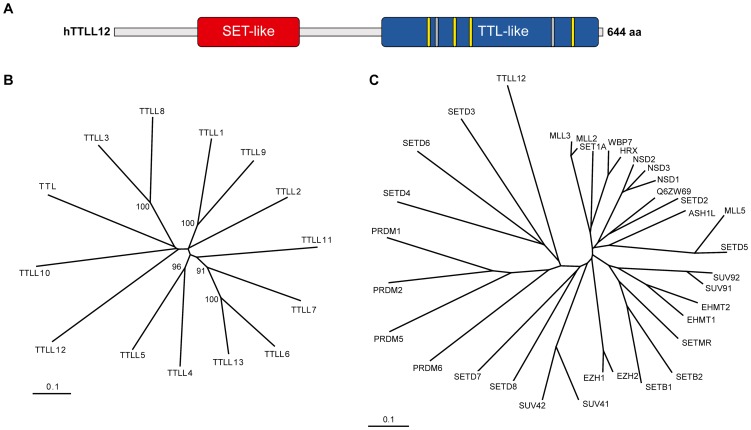
hTTLL12, domain organisation and similarity with other proteins.
A. Schematic representation. Red indicates the SET-like domain (amino acids 91–249), blue the TTL-like domain (amino acids 353–642), yellow or grey the predicted ATP and Mg2+ binding amino acid motifs that are respectively conserved (WICK416–419, SKYI450–453, DIRY470–473, EVN605–607), or non-conserved (SLDT426–429 and RAMYAVD578–584) in hTTLL12. B, C. Phylogenetic trees of the TTL domains of the human TTL family based on Alignment S1
(B) and the SET-like domain of hTTLL12 and human SET domains based on Alignment S2
(C). Bootstrap values are provided for significant nodes when they are >80%. Multiple sequence alignments are available as data.